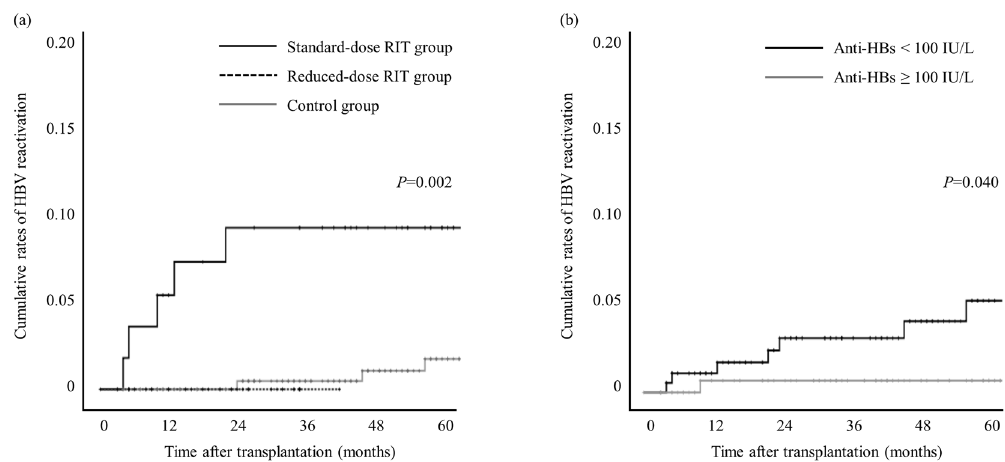
Figure 2. Cumulative rates of HBV reactivation. ( a ) HBV reactivation according to rituximab dose. ( b ) HBV reactivation according to anti-HBs titers at the time of transplantation (anti-HBs < 100 IU/L vs. anti-HBs ≥ 100